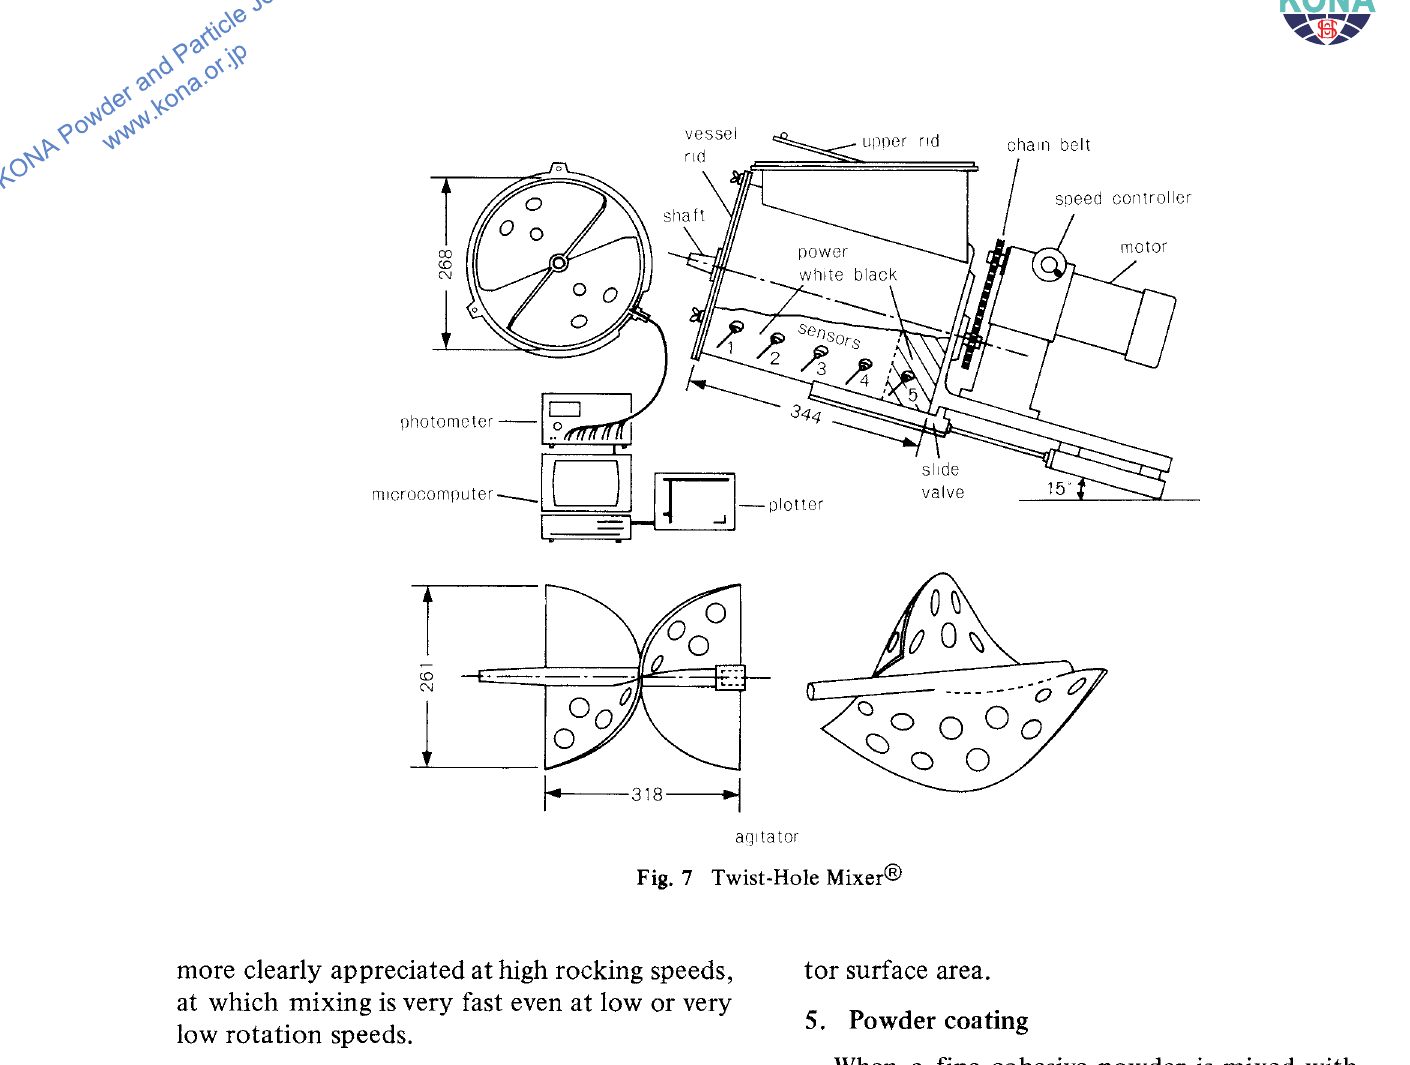
Fig. 7 Twist-Hole